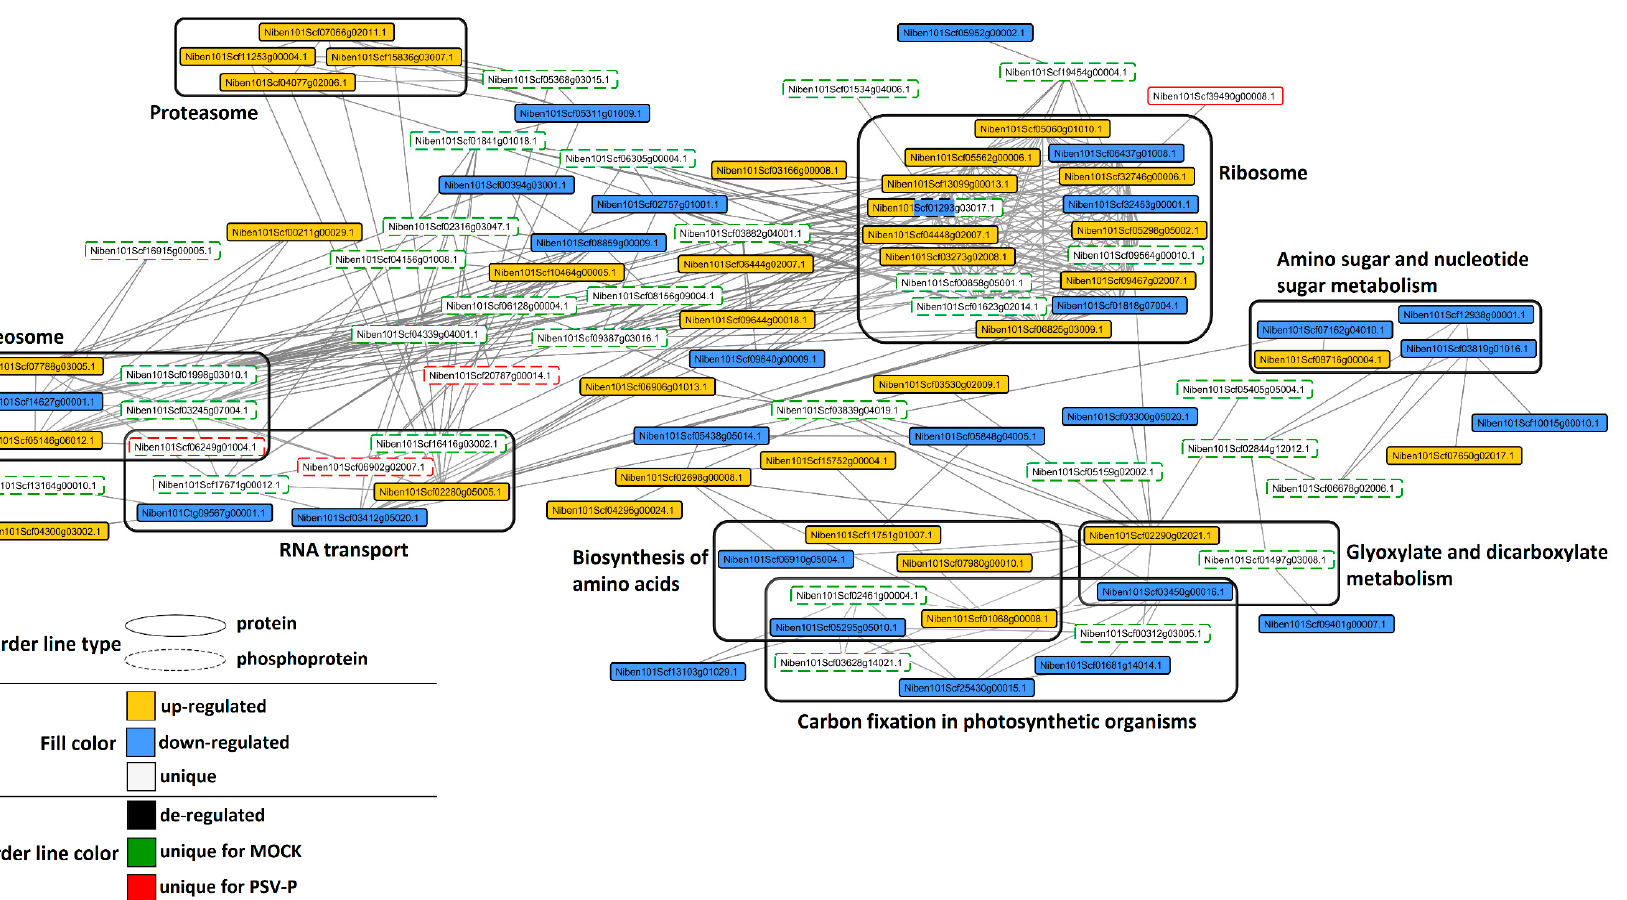
Figure 8. Protein–protein interaction networks of N. benthamiana PSV-P-responsive (phospho)proteins, differentially changed in their abundance. Cytoscape was used for visualization with SolGenomics N. benthamiana identifiers for (phospho)proteins. Grouping according to KEGG pathways was done for at least three interacting (phospho)proteins.